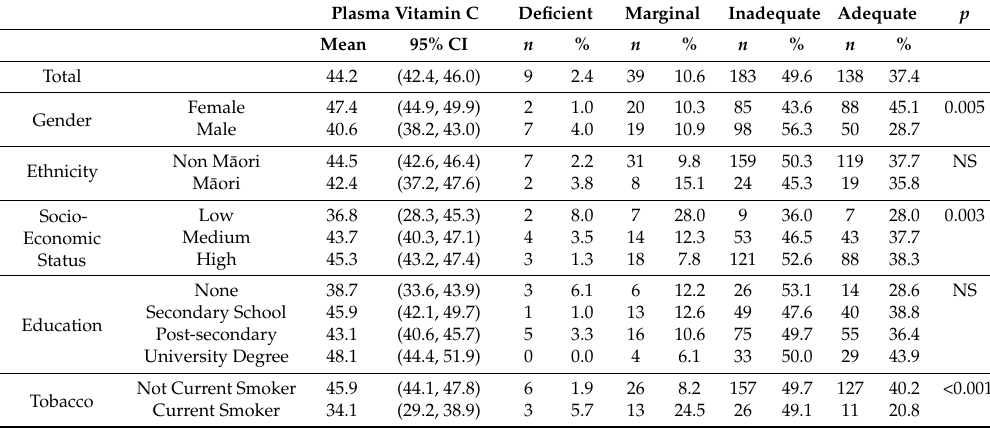
Table 3. Categories of vitamin C status.